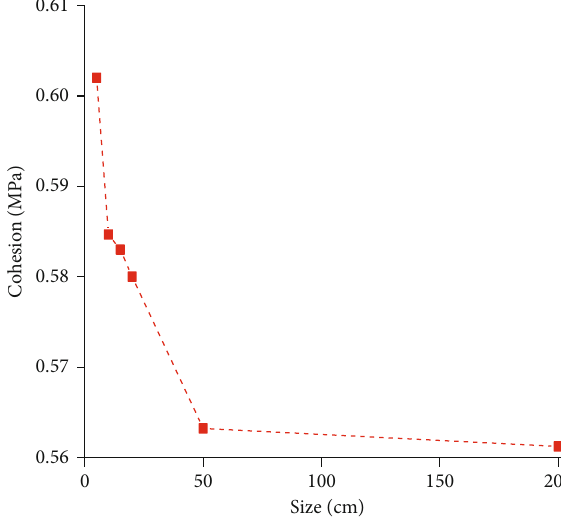
Figure 7: Relationship between the cohesion and model